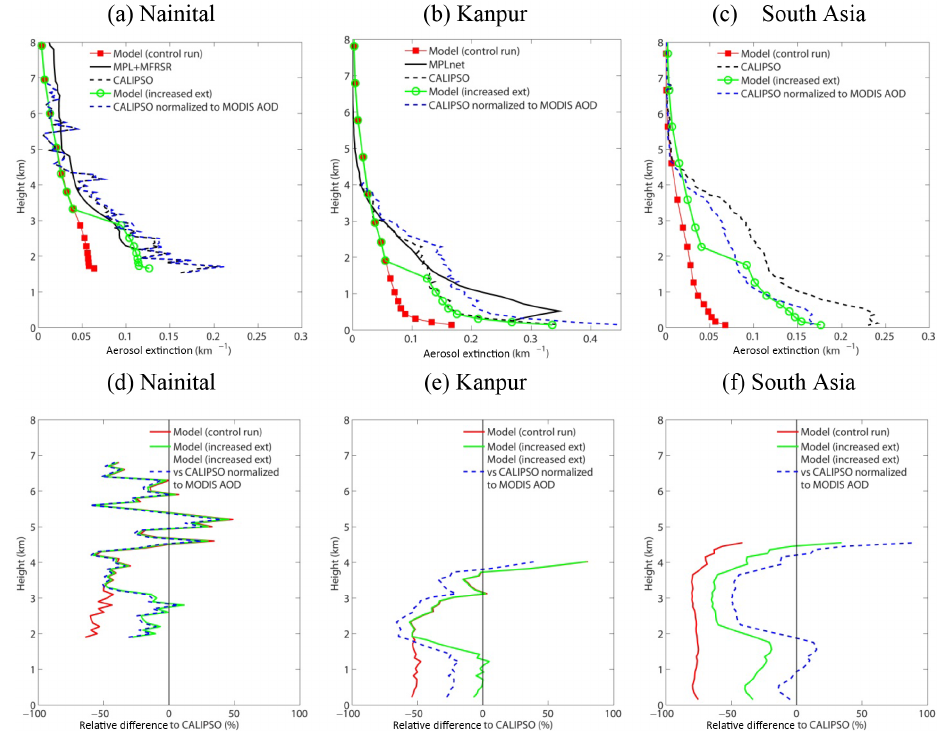
Figure 2. Comparisons of monthly mean aerosol extinction profiles from model calculations at 550nm (red squares for the control run and green open circles for the sensitivity studies), ground-based MPL data at 532nm (solid black), satellite-retrieved CALIPSO data at 532nm (dashed black), and CALIPSO data normalized to the MODIS AODs (dashed blue) (a) at Nainital, (b) at Kanpur, and (c) over South Asia (60–95 ◦ E, 0–30 ◦ N), respectively. The column-mean uncertainty in CALIPSO extinction data is ± 110, ± 93, and ± 91% in panels (a) – (c) ; percent differences between the simulated and CALIPSO profiles are shown for (d) Nainital, (e) Kanpur, and (f) South